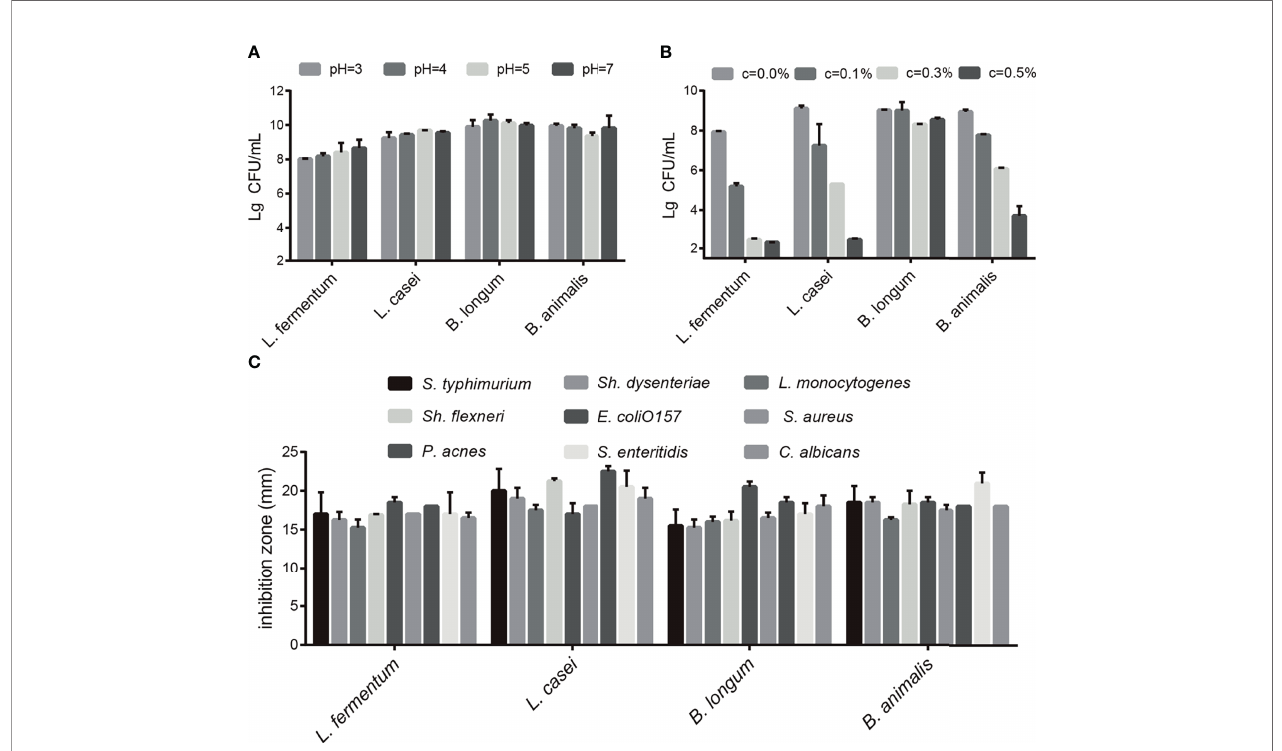
FIGURE 1 | Evaluation of the probiotic characteristics of L. fermentum SX-0718, L. casei SX-1107, Bi fi dobacterium SX-1326, and B animalis SX-0582. (A) The acid tolerance of L. fermentum SX-0718, L. casei SX-1107, B longum SX-1326 and B animalis SX-0582. (B) The cholate tolerance of L. fermentum SX-0718, L. casei SX-1107, B longum SX-1326 and B animalis SX-0582. (C) Antibacterial activities of L. fermentum SX-0718, L. casei SX-1107, B longum SX-1326 and B animalis SX-0582 on Salmonella typhimurium ATCC 13311, Shigella fl exneri ATCC 12022, P ropionibacterium acnes ATCC 11827, Sh. dysenteriae 301, Escherichia coli O157, S. enteritidis ATCC 13076, Listeria monocytogenes ATCC 19111, Staphylococcus aureus Cowan1 and Candida albicans